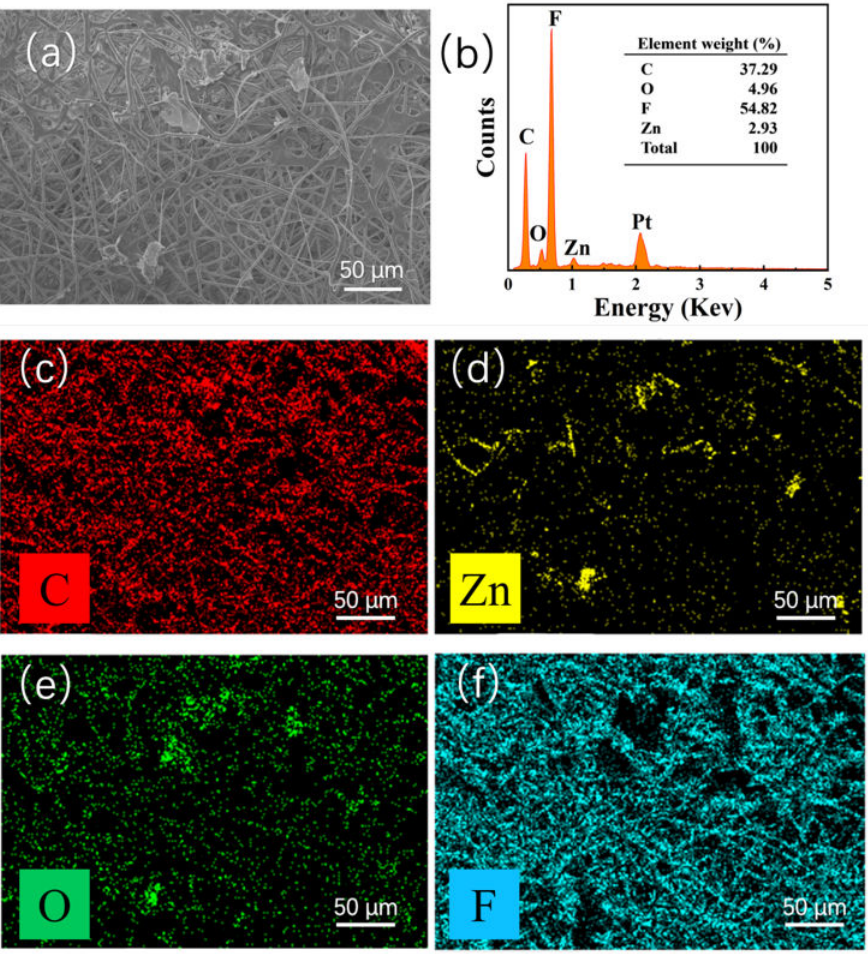
Figure 3. EDS of the ZnO@PVDF composite membrane (ZnO/PVDF = 1:3, w / w ). ( a ) SEM image of the overview. ( b ) Elemental content analysis. ( c – f ) Elemental mapping, showing C, Zn, O, and F